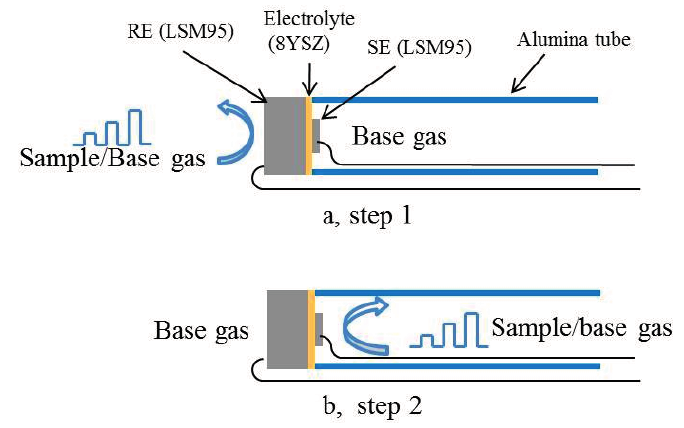
Figure 2. Schematic illustration of NO 2 sensors measured in the two-chamber